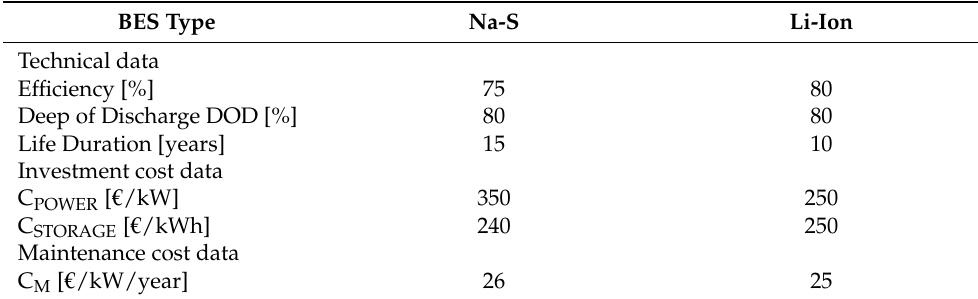
Table 2. Data assumed for techno-economic BES